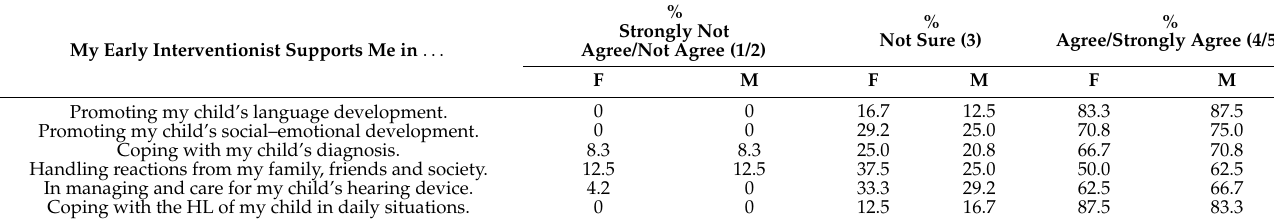
Table 5. Perceived support by FCEI.